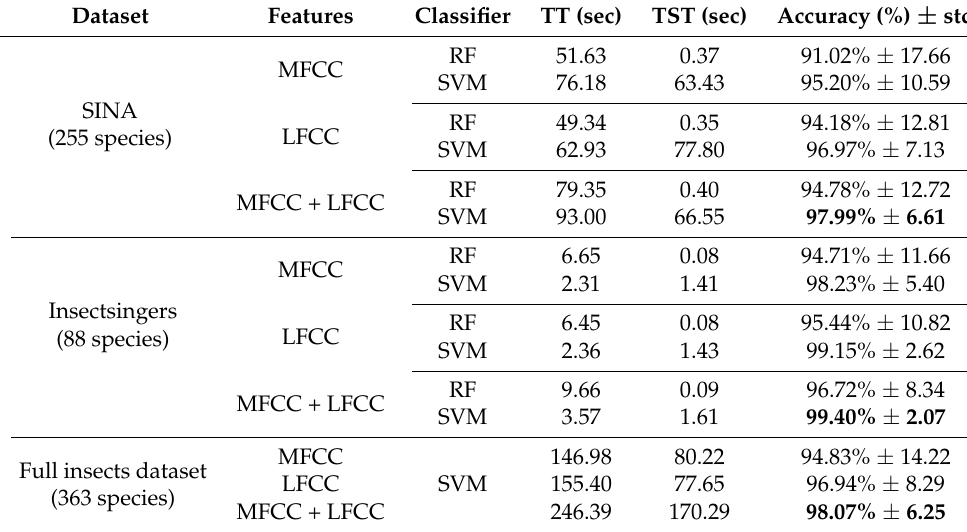
Table 1. Classification